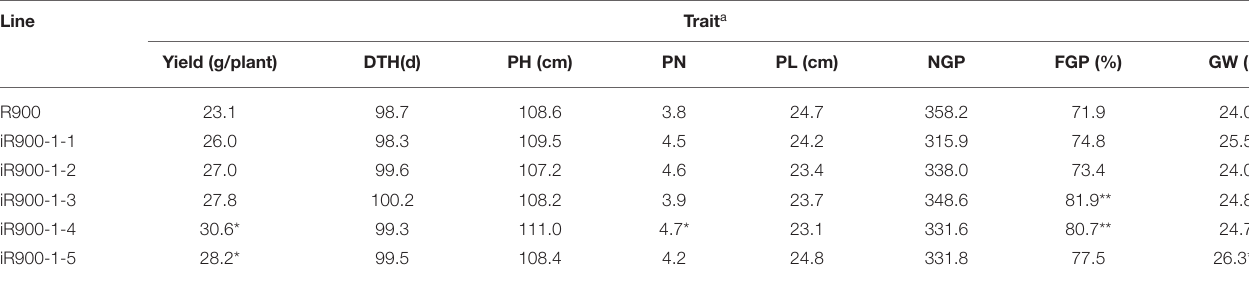
TABLE 4 | The performance of yield and main agronomic traits of the iR900 lines containing genes Xa23 + Pi9 . Line Trait